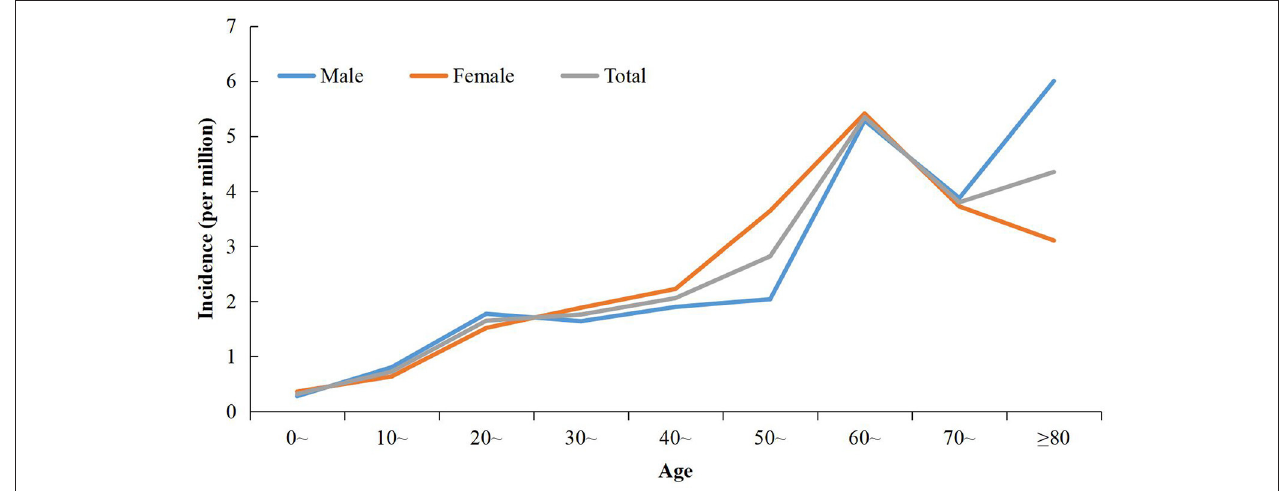
FIGURE 3 | Age-specific incidence of indigenous dengue in Zhejiang Province during